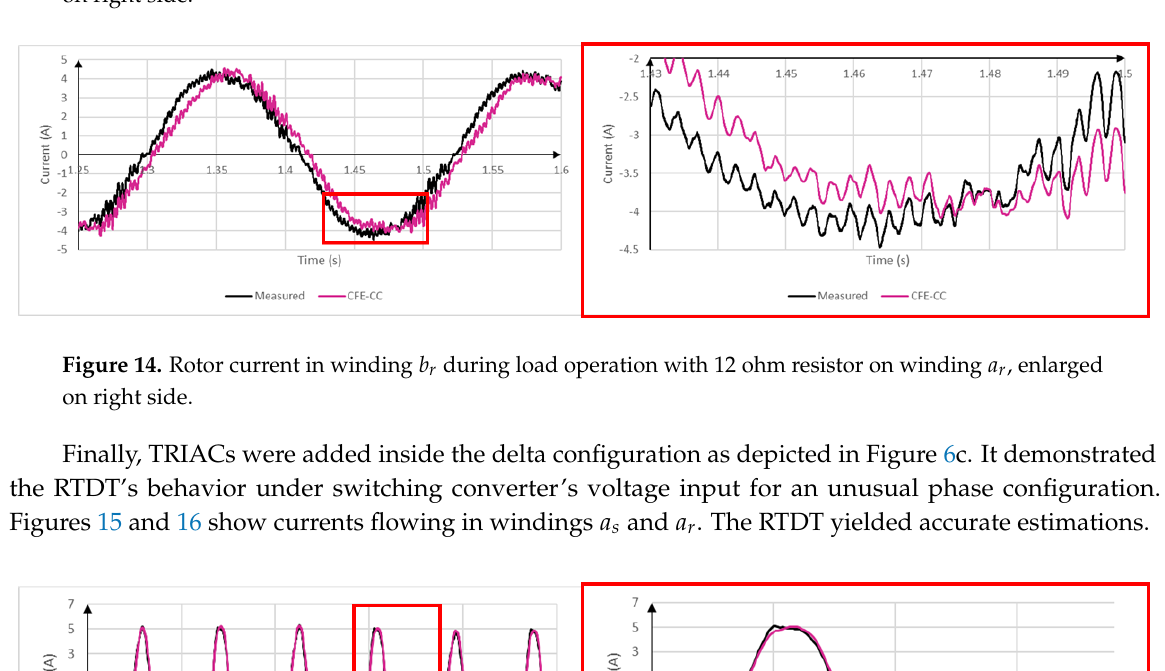
Figure 13. Rotor current in winding a r during load operation with 12 ohm resistor on winding a r , enlarged on right side.